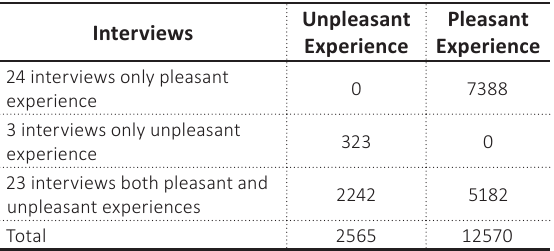
Table 3. Pleasant and unpleasant experiences in each interview (number of